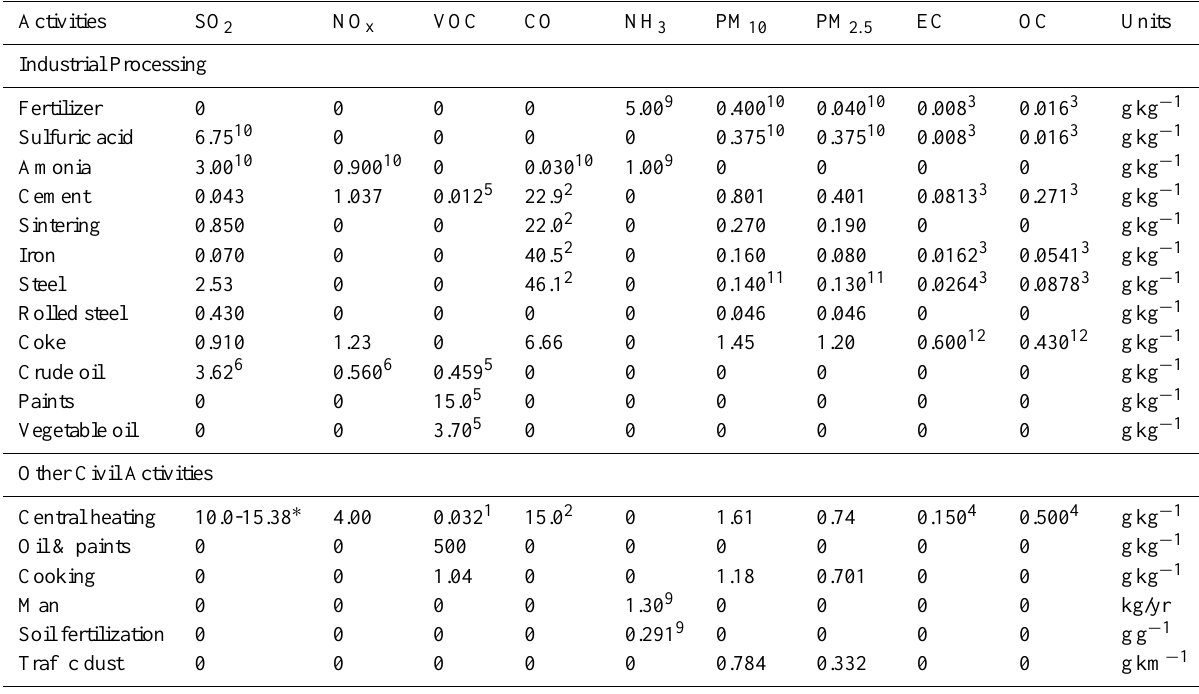
Table 7. Emission factors for industrial processing and other civil activities.